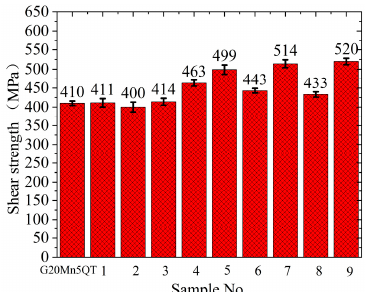
Figure 8. Micro-shear strength of